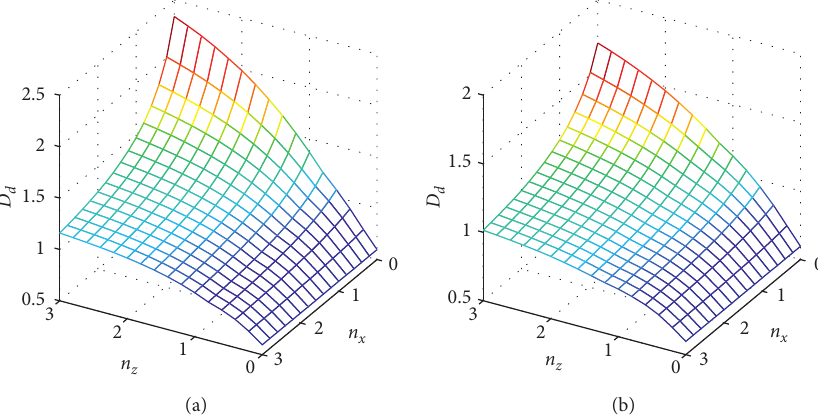
� 0.5, n � 0.5, n x z is variable. (b) n z x is variable.